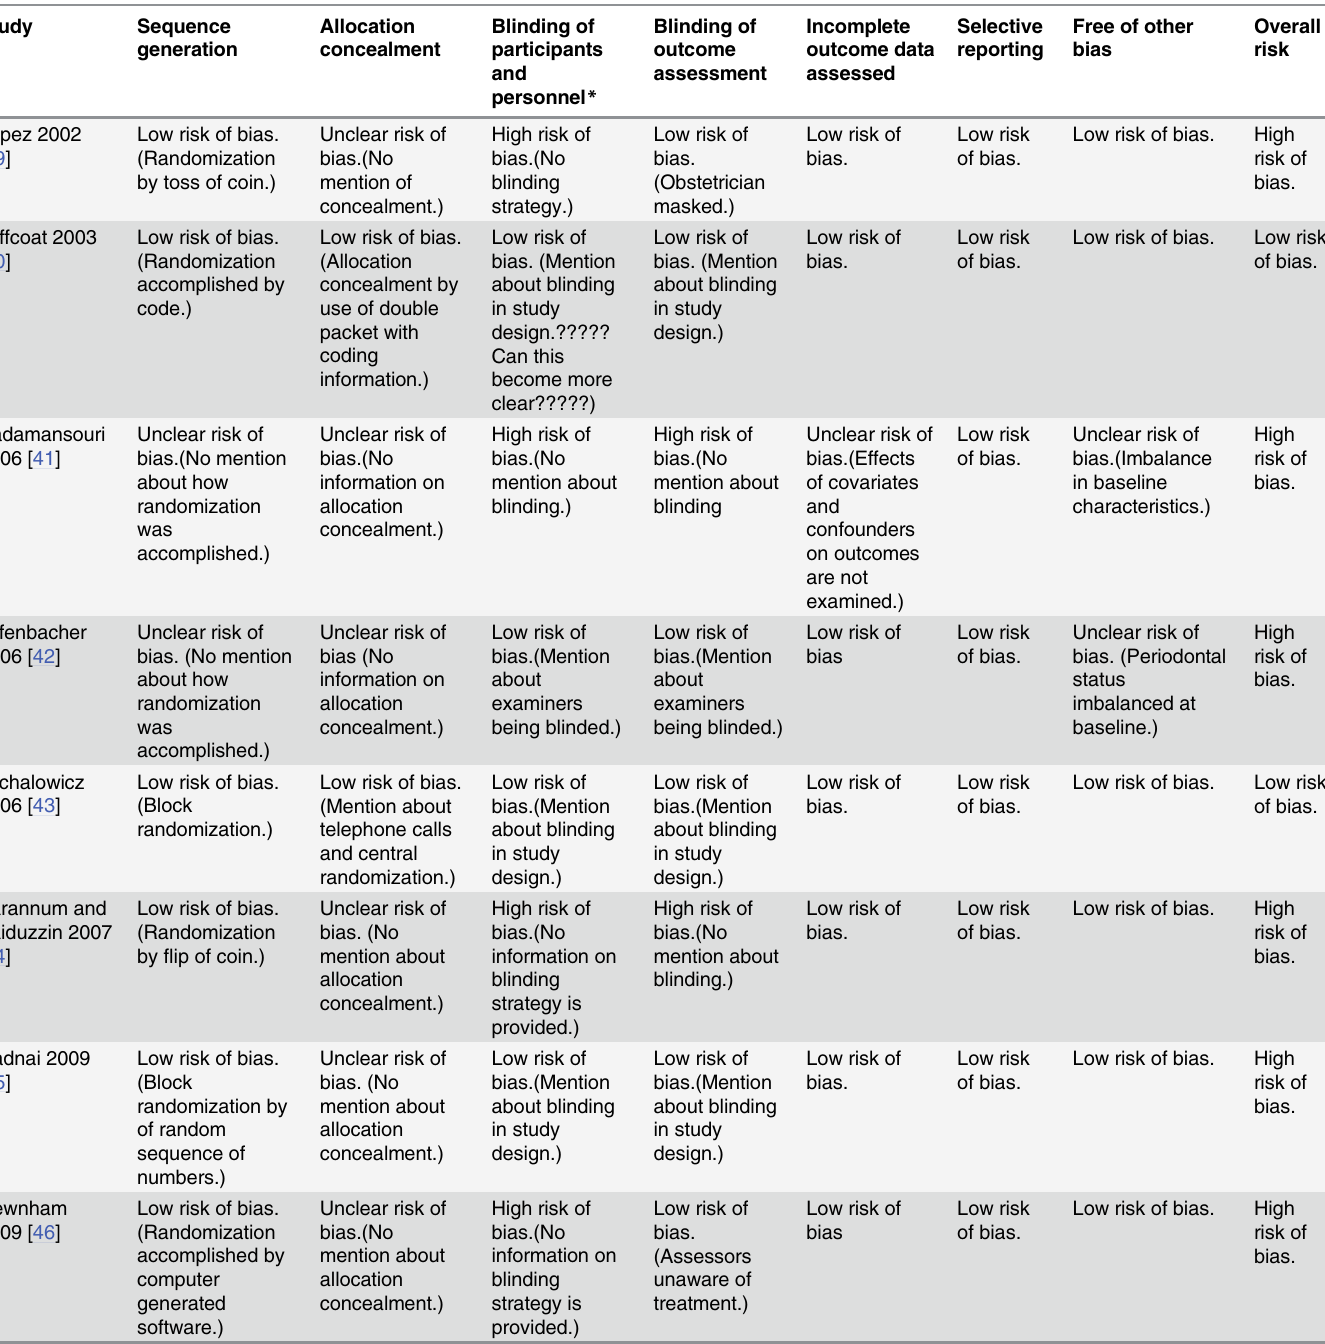
Table 1. Risk of bias of the included